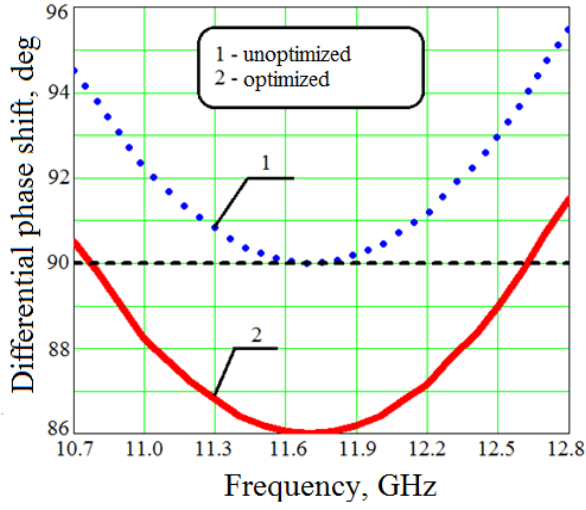
FIGURE 3. The differential phase shift of a square waveguide polarization converter with three diaphragms In Fig. 3, we can see that for a non-optimized polarizer, the differential phase shift varies within 90° ± 5.5° in the operating frequency range. At 11.7 GHz, the differential phase shift becomes 90°. From Fig. 2 for the optimized polarizer, it can be seen that the differential phase shift is equal to 90° at frequencies of 10.76 GHz and 12.63 GHz. In the operating Ku range of 10.7–12.8 GHz, the differential phase, rectangular optimized waveguide polarizer shift with three diaphragms varies from 86° to 91.6°. The maximum deviation of the differential phase shift from 90° is 4° and is carried out at a frequency of 11.7 GHz, which is close to the central frequency of the operating